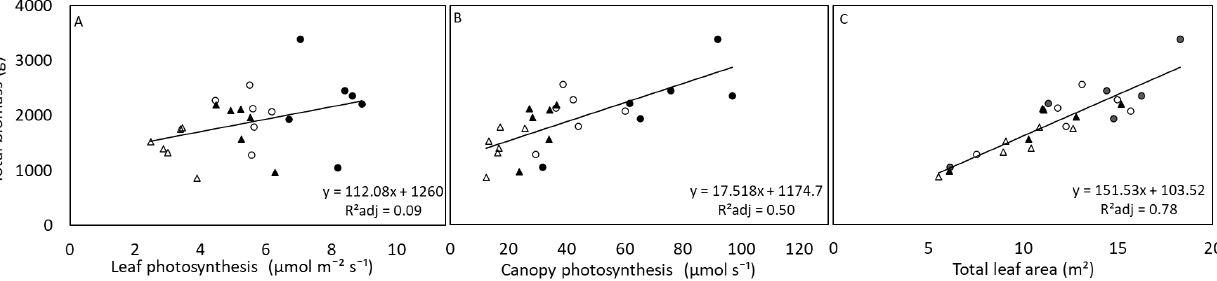
Figure 6. Relationships between total biomass and leaf-level net photosynthesis ( A ), canopy photosynthesis ( B ), and total leaf area ( C ). Final aboveground biomass was most strongly related to tree leaf area ( C ). Open circles: WW–ambient CO 2 , closed circles: WW–elevated CO 2 , open triangles: WD–ambient CO 2 , closed triangles: WD–elevated CO 2 . Flush interval was, on average, 16 days longer in trees grown under WD compared Table 1. Leaf traits measured on six genotypes of cacao grown under ambient and elevated CO 2 and well-watered and water deficit treatment (mean ± standard error of mean). A significant effect of each of the main factors is indicated by an asterisk (*** denotes significance at p < 0.001; ns: not significant). Genotype Ambient CO 2 Elevated CO 2 Well-Watered Water Deficit Well-Watered Water Deficit Stomatal CL 19/10